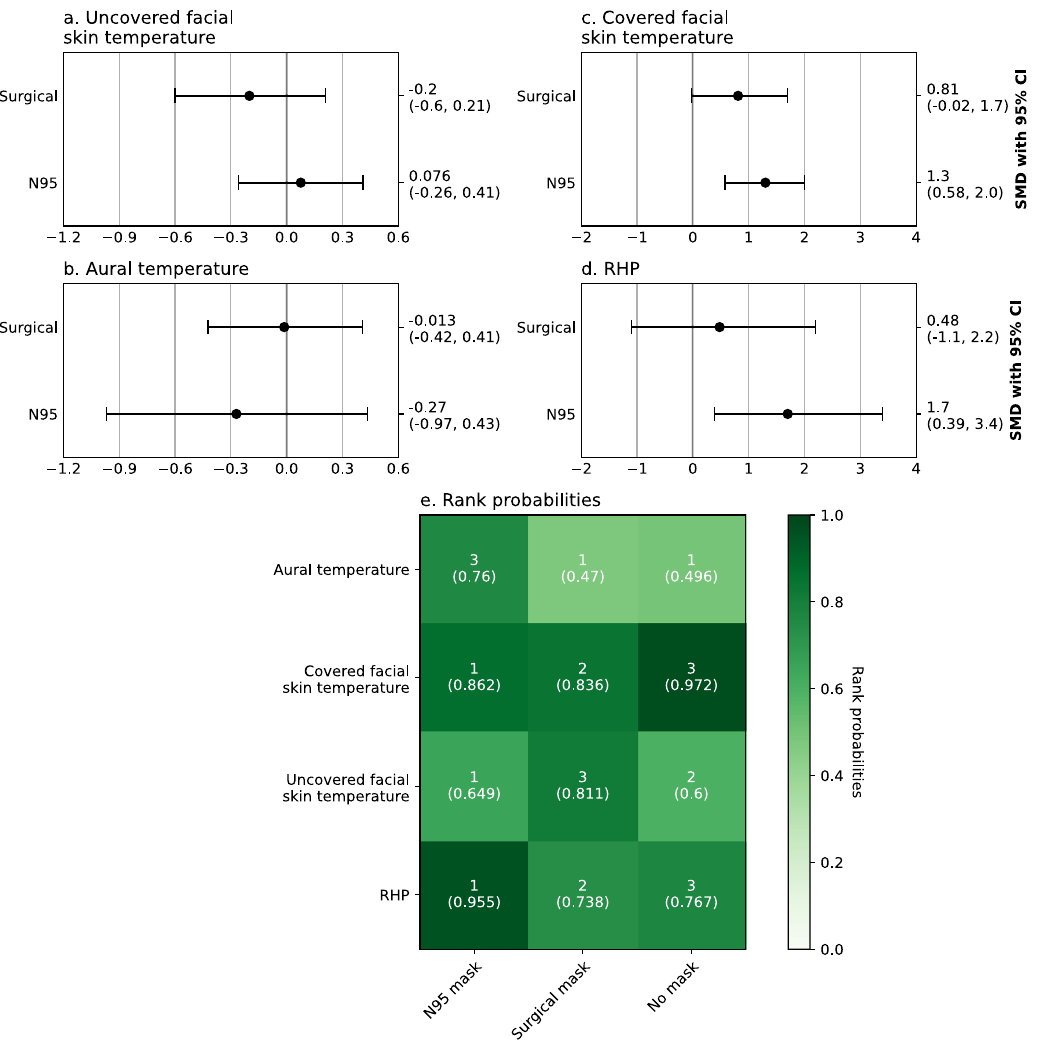
Figure 5. Network meta-analysis of N95 filtering facepiece respirators and surgical masks’ effects on thermoregulation. Numbers in rank probabilities heatmap represent rank with the highest probability and corresponding probability for given measure and condition; RHP a subjective rating of heat